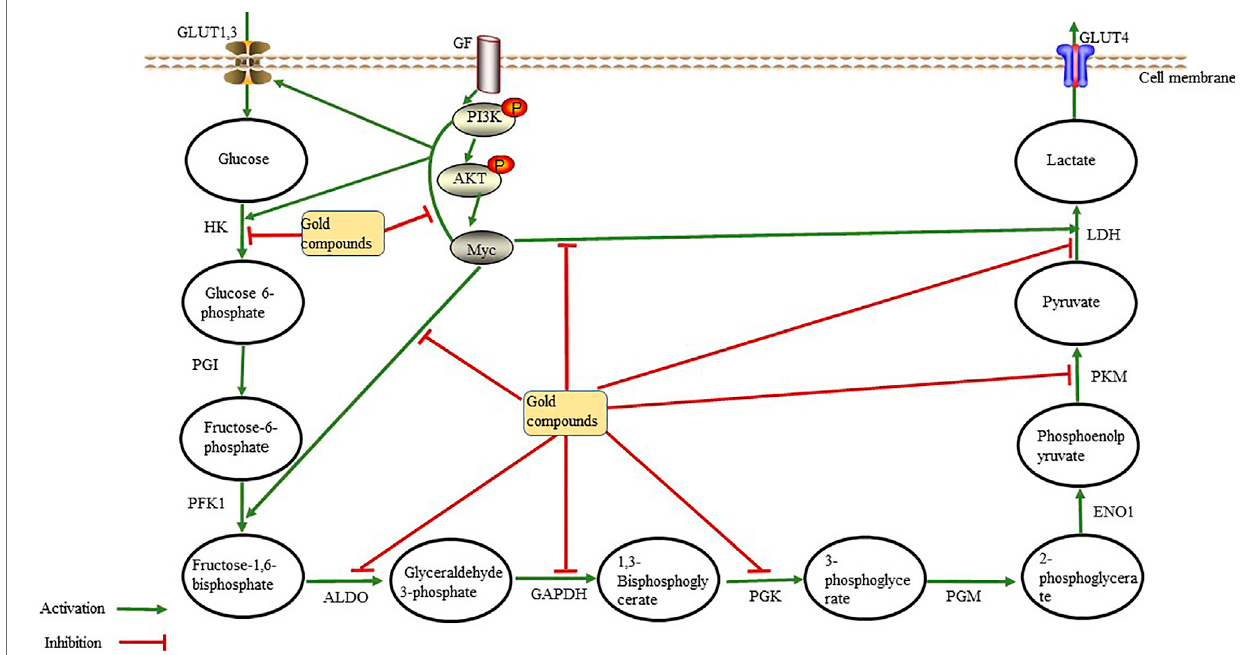
FIGURE 2 | Gold compounds inhibit glycolytic enzymes through the phosphoinositide 3-kinase (PI3K)/Akt signaling pathway and the Myc oncogene. They also directly inhibit the activity of glycolytic enzymes, thereby reducing lactate and ATP production, leading to anti-tumor effects Abbreviations: ALDO, aldolase; ENO1, enolase; GAPDH, glceraldehyde-3-phosphate dehydrogenase; GF, growth factor; GLUT, gulcose transporter; HK, hexokinase; LDH, Lactate dehyrogenase; PFK1, phosphofructokinase 1; PGI, phosphoglucoisomerase; PGK, phosphoglycerate kinase; PGM, phosphoglcerate mutase; PKM, pyruvate kinase.